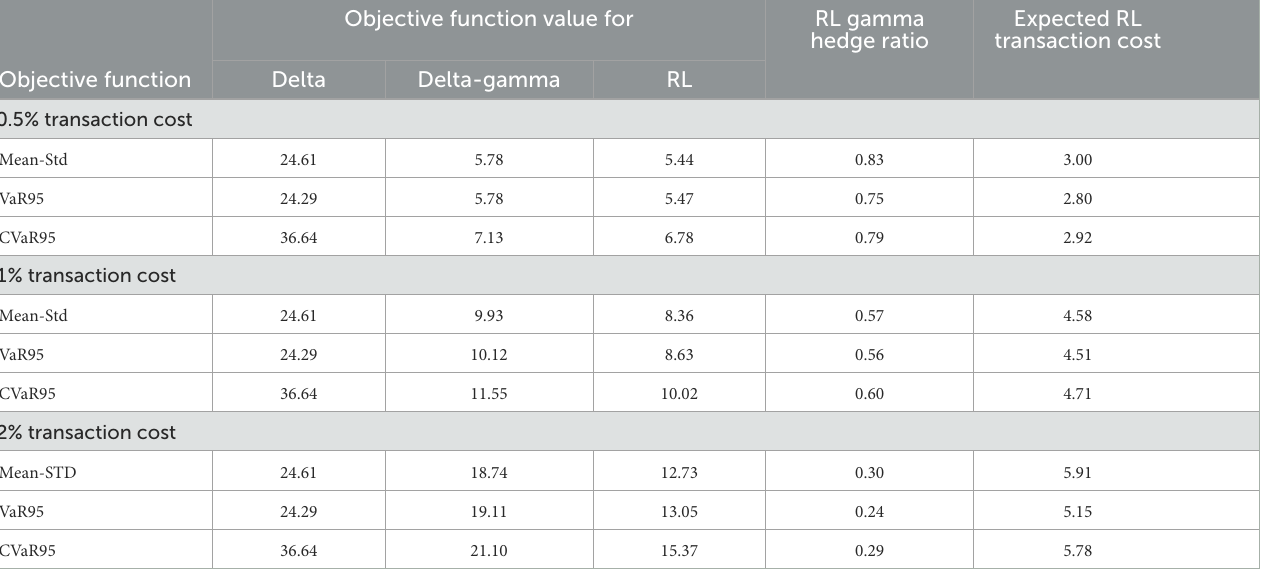
TABLE 1 Results of tests when volatility is constant.